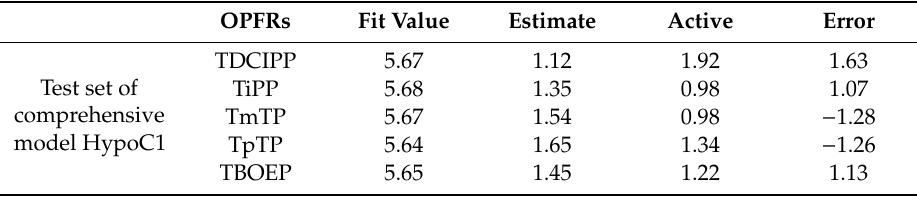
Table 3. Comprehensive evaluation value comparative results of HypoC1 and OPFR test